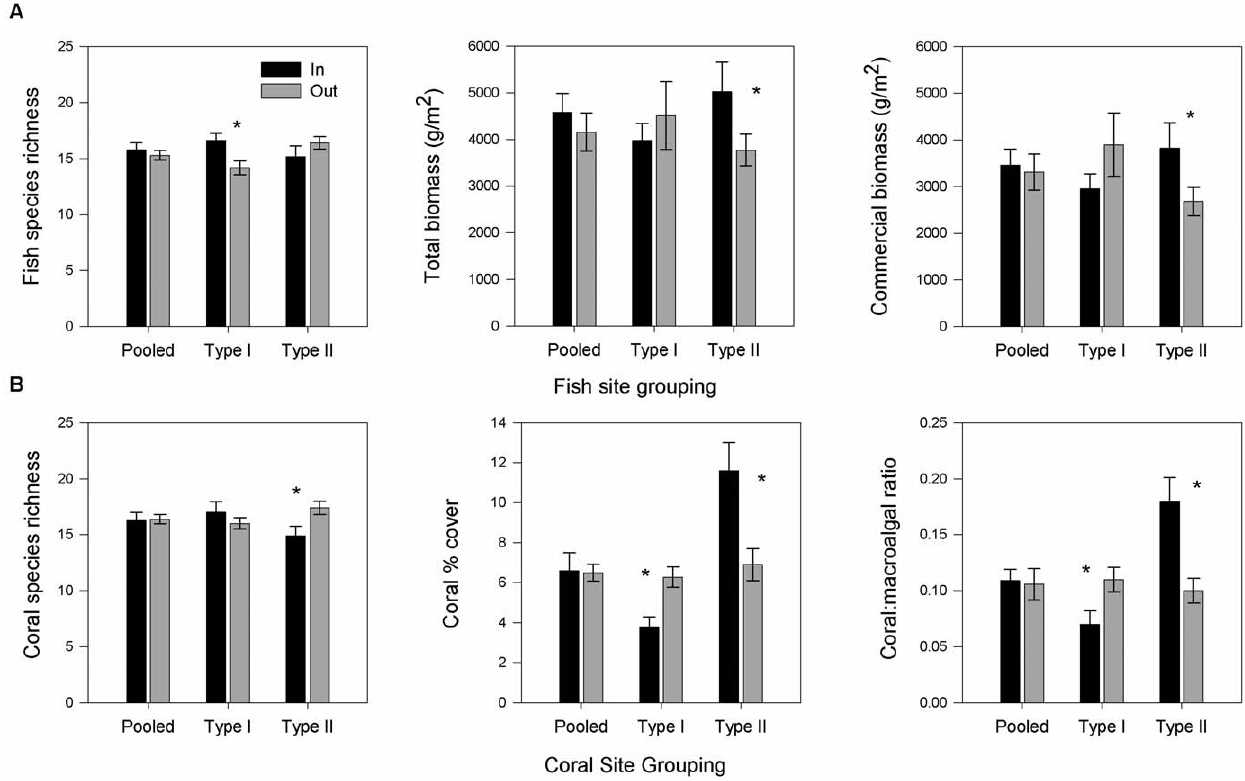
Figure 3. Reserve responses for pooled versus clustered sites. Fish response variables (A) shown in top panels and coral response variables (B) on bottom panels. Significant differences (P , 0.05) between in (dark bars) and outside reserve (light bars) are denoted with an